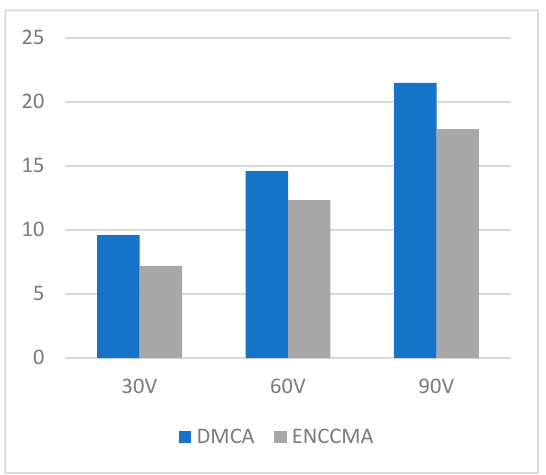
Figure 3. Throughput for the city environment.